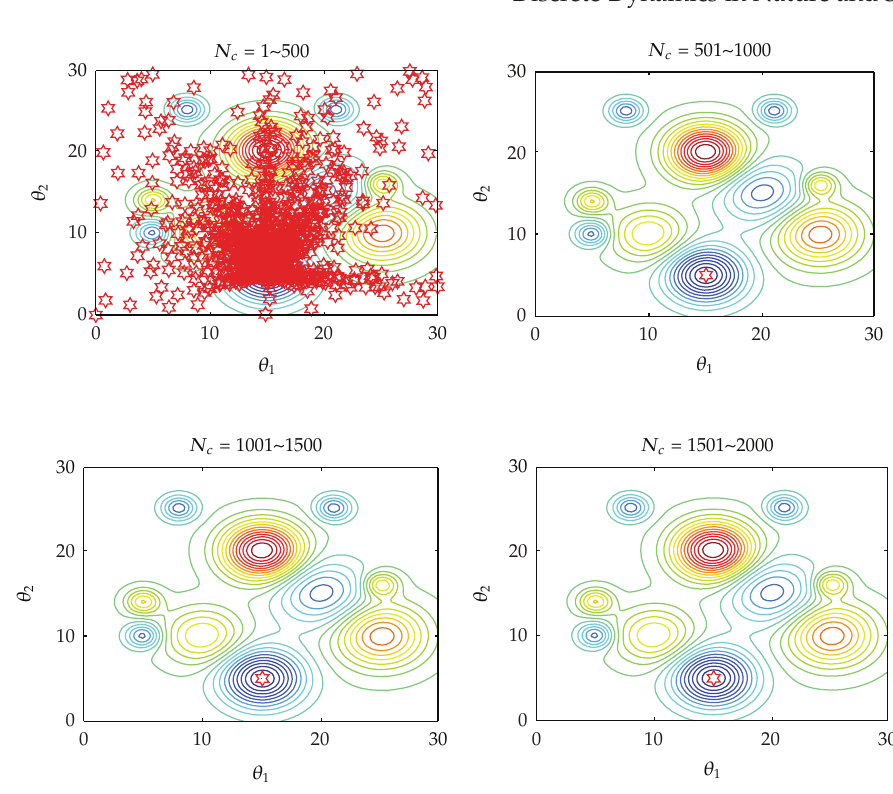
Figure 12: The process of finding the